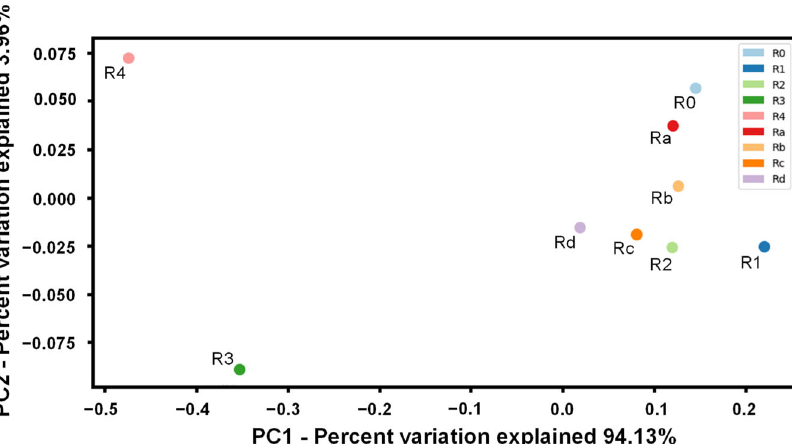
Fig. 4 Weighted 2D principal coordinate analysis (PCoA) plot of the microbial communities in the IBPR. R0 indicates suspended fl ocs; Ra – Rd indicate attached bio fi lms on each bioplate; R1 – R4 indicate biomass entrapped in the bioplates, as shown in Fig.